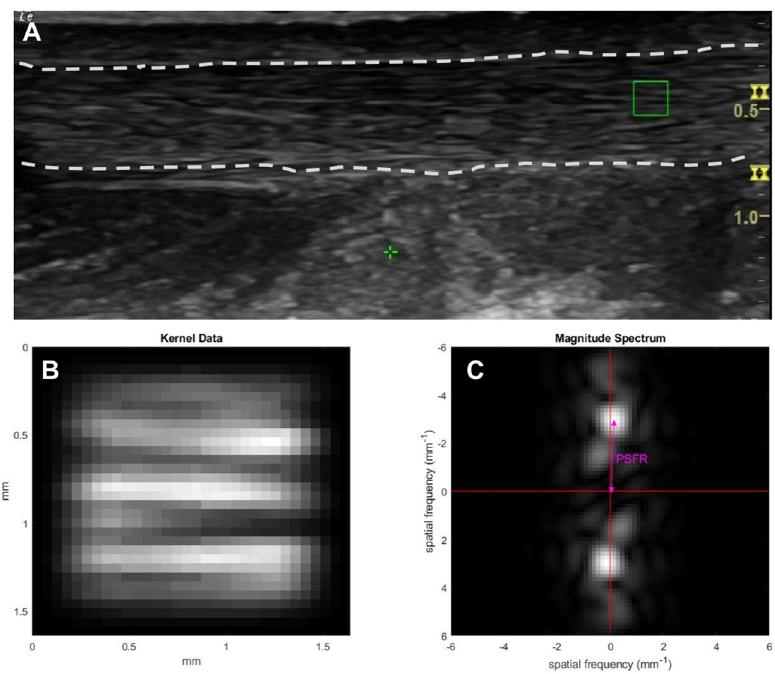
Fig 1. Frequency analyses of an Achilles tendon ultrasound image. (A) Original B-mode image with a sample kernel (green rectangle); (B) the zoomed data and spectrum of the kernel; (C) corresponding frequency spectrum of the selected kernel with a double arrow denoting peak spatial frequency radius. Area between the two dashed lines on the B-mode image is the Achilles tendon.